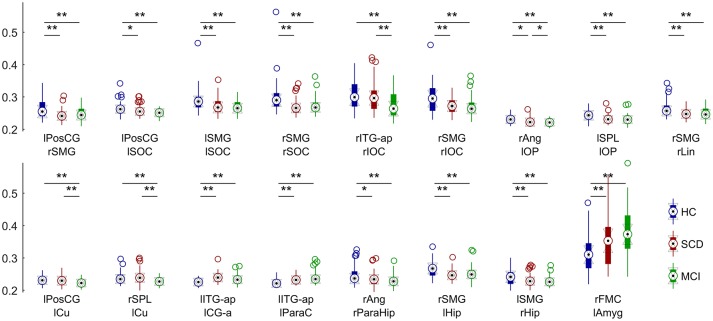
Distribution of connectivity values in each significantly different link for HC (blue), SCD (red) and MCI (green) groups. Asterisks mark significantly different connectivity values between groups. One asterisk (*) denotes a p-value between 0.05 and 0.01. Two asterisks (**) denote a p-value lower than 0.01.